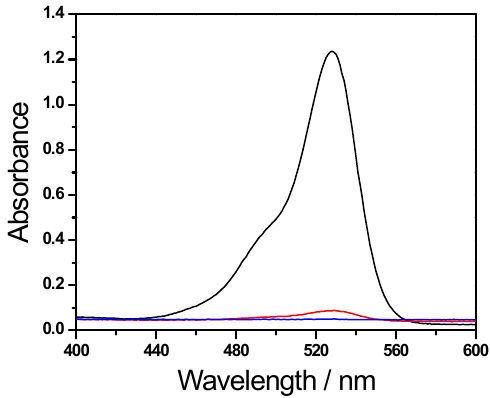
Figure 6. UV-Vis spectra of the ethanol solutions used for washing the MIF@GO-AgNPs sample (black curve for first washing, red curve for the second washing, and blue curve for the third washing).